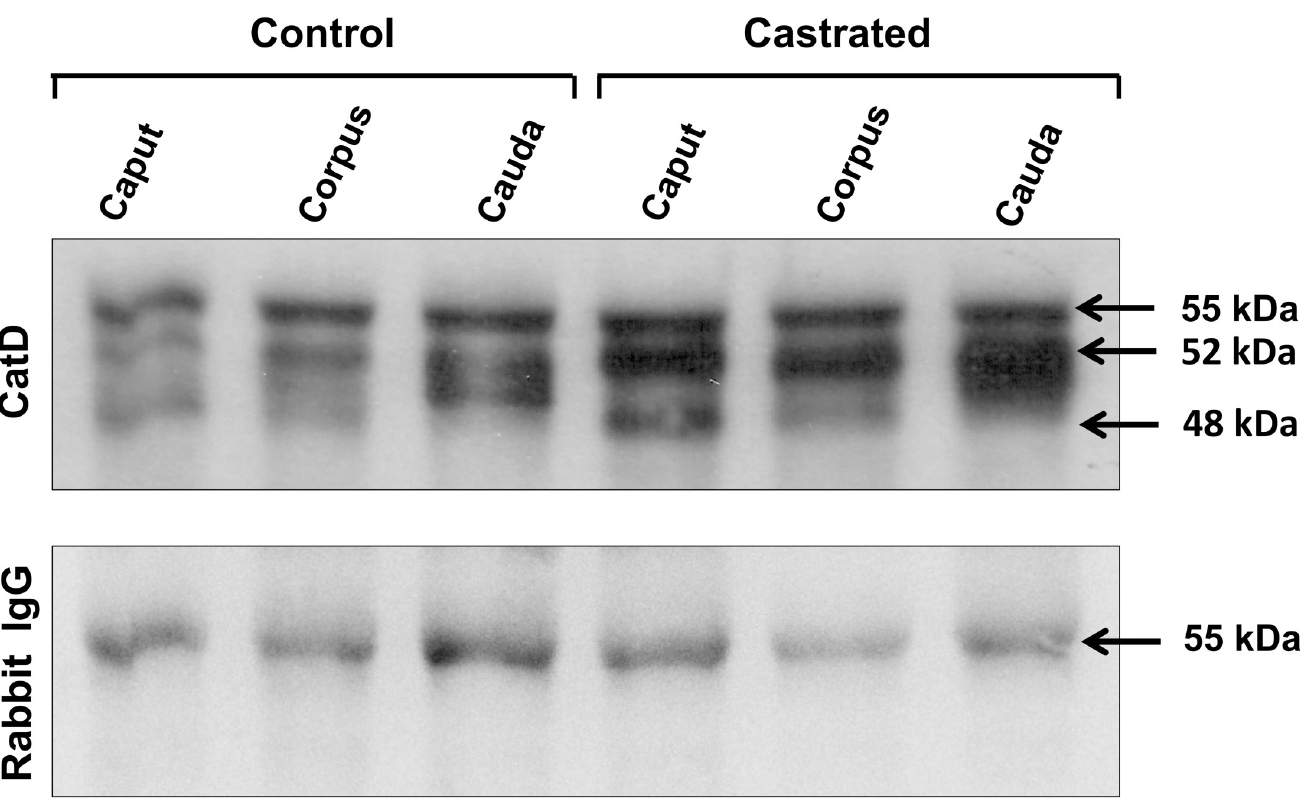
Fig 9. Co-immunoprecipitation of cathepsin D with prosaposin. Epididymal fluid from control versus castrated rats were mixed with beads preincubated with anti-PSAP antibody, as described in Materials and methods. After centrifugation and washing, cathepsin D was detected from the precipitates by immunoblot. Immature (52 kDa) bands of the enzyme were detected in the precipitates. Detection of IgG (55 kDa, heavy chain) was used as a loading control. The figure is representative of two independent experiments.